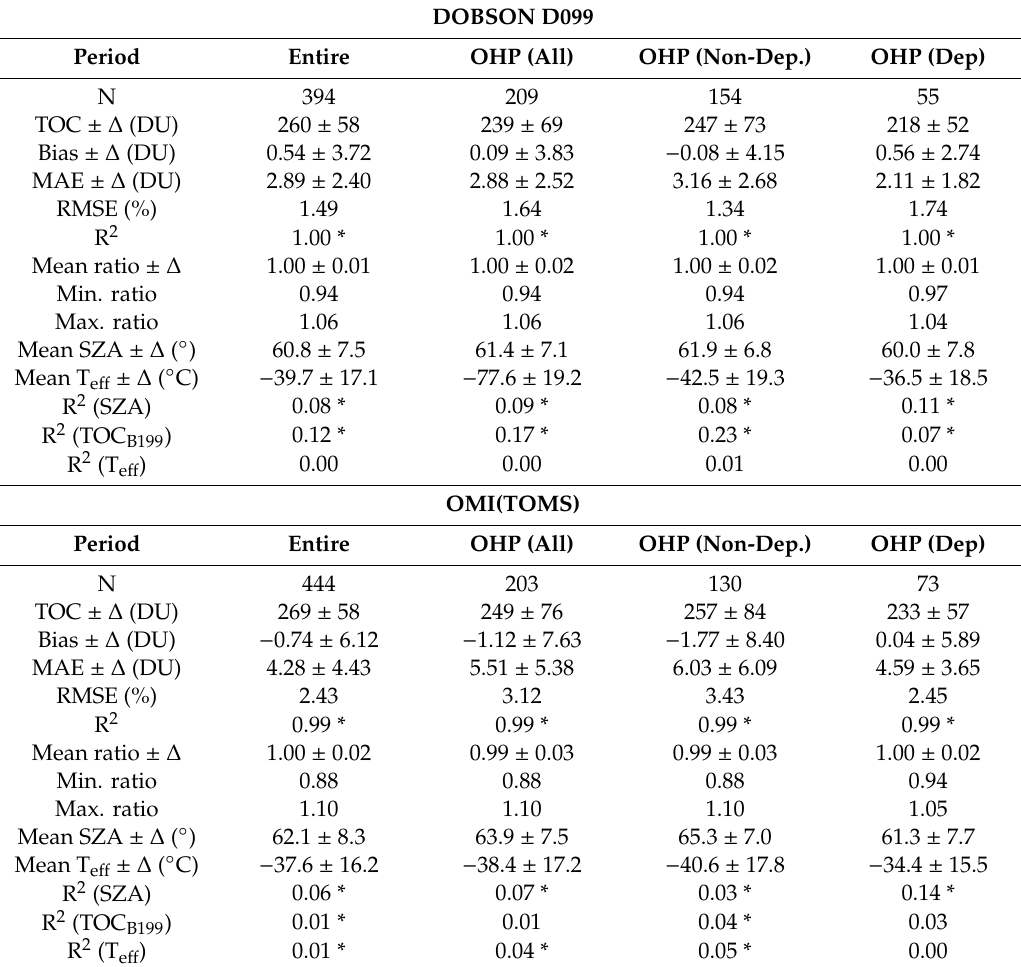
Table A1. Statistical characteristics calculated for individual data sources (asterisks indicate statistically significant ( α = 0.05)